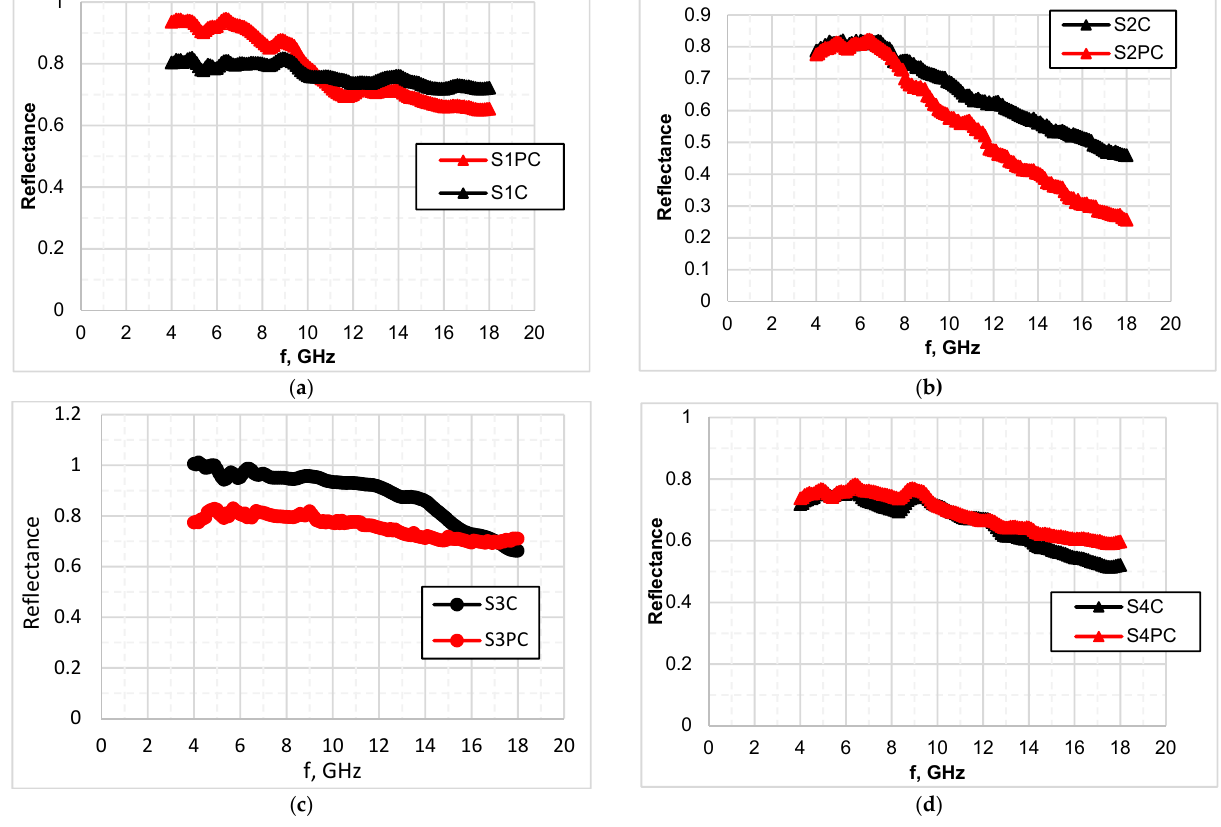
Figure 8. Reflectance of tested fabrics coated with PEDOT:PSS formulation: ( a )—I group of samples; ( b )—II group of samples; ( c )—III group of samples; ( d )—IV group of samples. Table 6. Microwave properties of tested coated